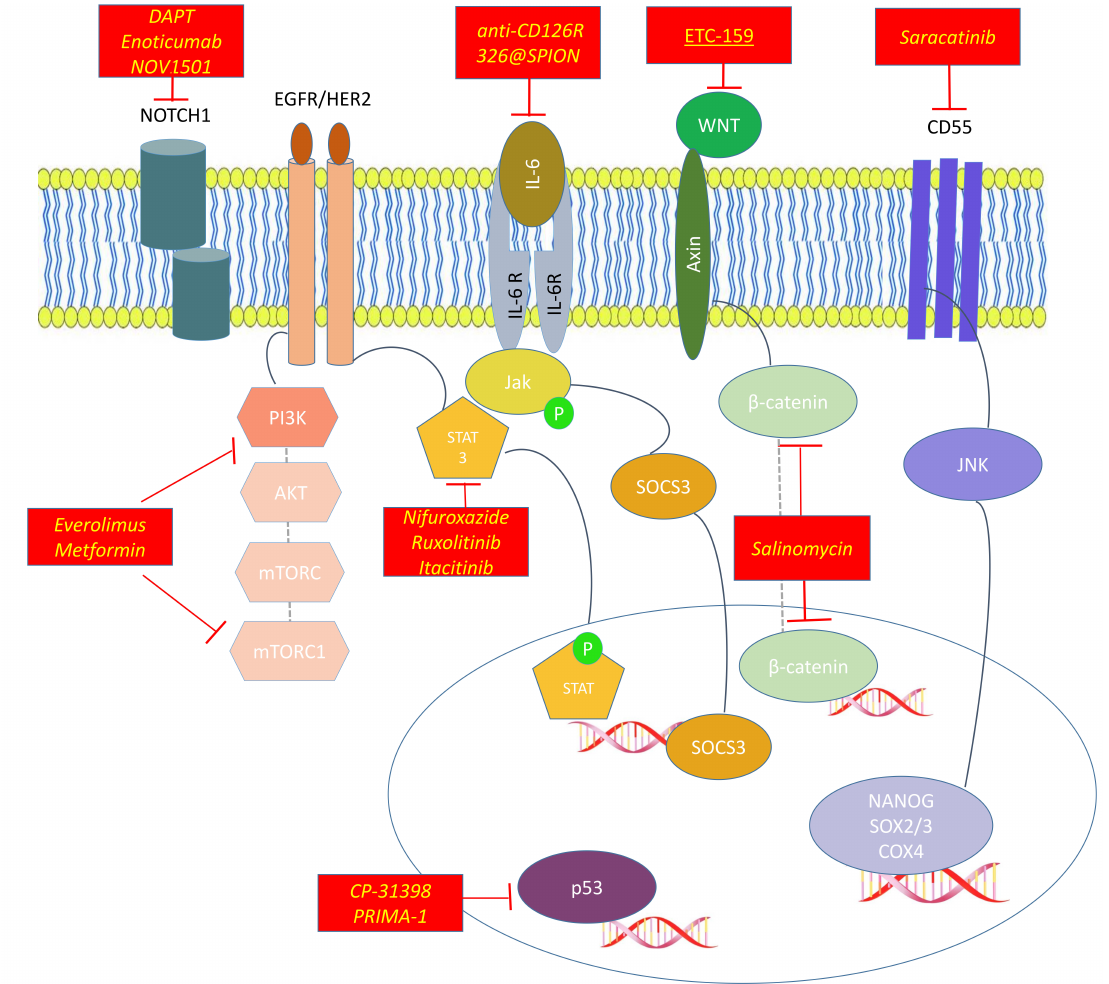
Figure 1. Activated pathways in Endometrial Cancer Stem Cells (CSCs) and their